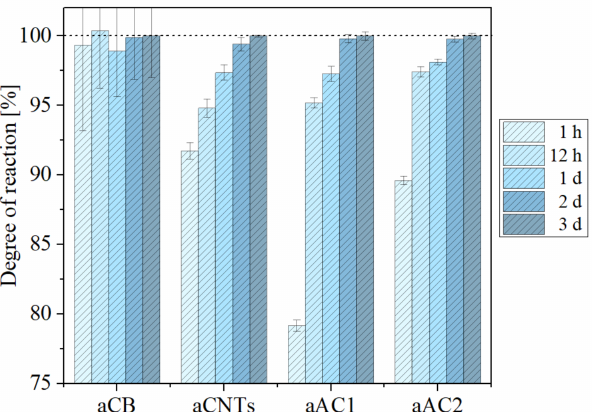
Figure 4. Consumption of NaOH as a function of time for the different carbons. 100% equals the consumption of NaOH after three days. Absolute values at 100% correspond to 0.2 mL (aCB), 0.9 mL (aCNTs), 2.6 mL (aAC1) and 3.6 mL